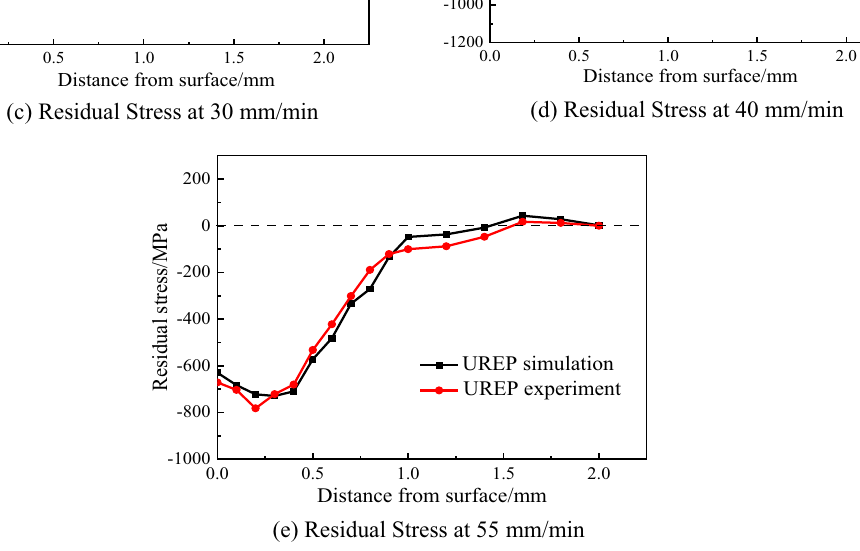
Figure 7. Residual stress of UREP at different feed